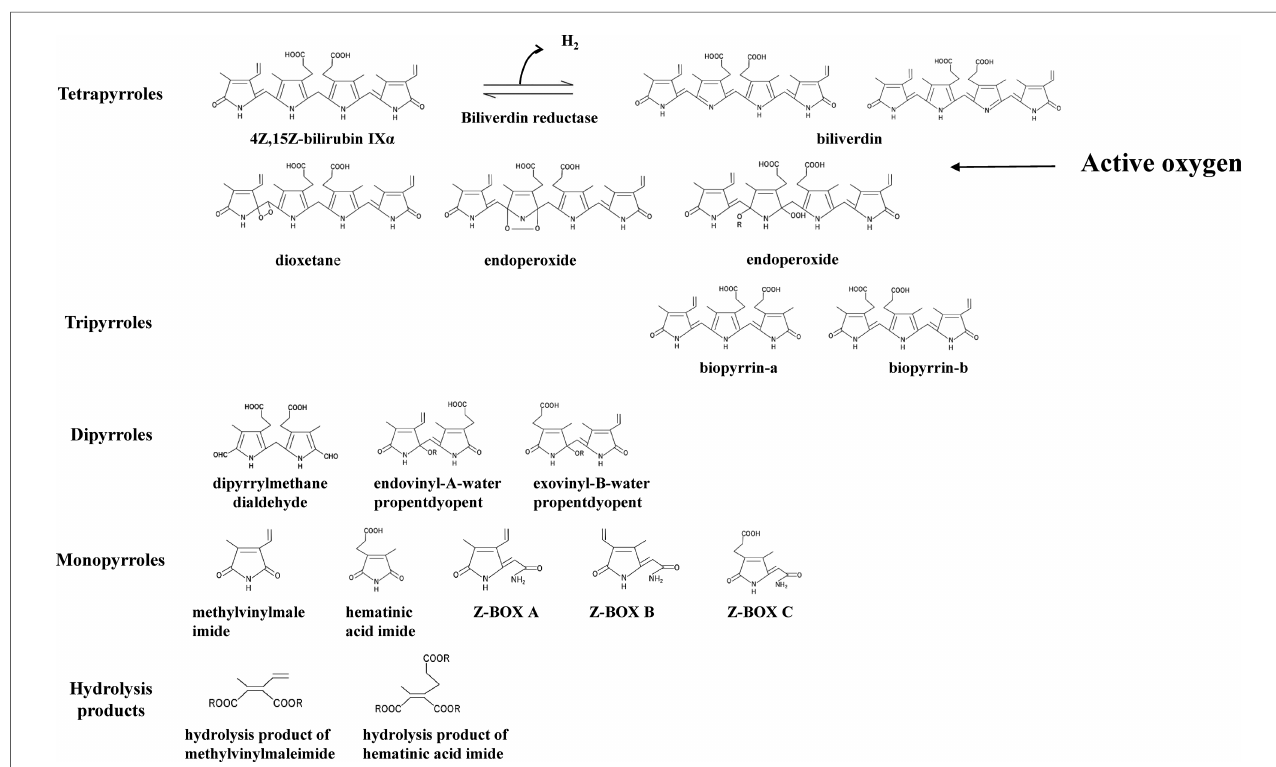
FIGURE 1 4Z,15Z -bilirubin IX α and bilirubin oxidation products. The bilirubin oxidation products formed from 4Z,15Z -bilirubin IX α are divided into tetrapyrroles, tripyrroles, dipyrroles, monopyrroles, and hydrolysis products with their corresponding structures. Bilirubin oxidation products produced by quenching activity: biliverdin. Bilirubin oxidation products produced by scavenging activity: oxidizing substances other than biliverdin. The abbreviations and the articles in which they are listed: biliverdin (23 – 26); biopyrrin-a and biopyrrin-b (27); exovinyl-B-water propentdyopent, endovinyl-B-water propentdyopent, and hematinic acid imide (28); Z-BOX, Z-bilirubin oxidant product; Z-BOX A and Z-BOX B (29); Z-BOX C (30); hydrolysis product of methylvinylmaleimide and hematinic acid imide (28); and exovinyl-B-water propentdyopent & endovinyl-B-water propentdyopent [propentdyopents determined by pentdyopent reaction (23,